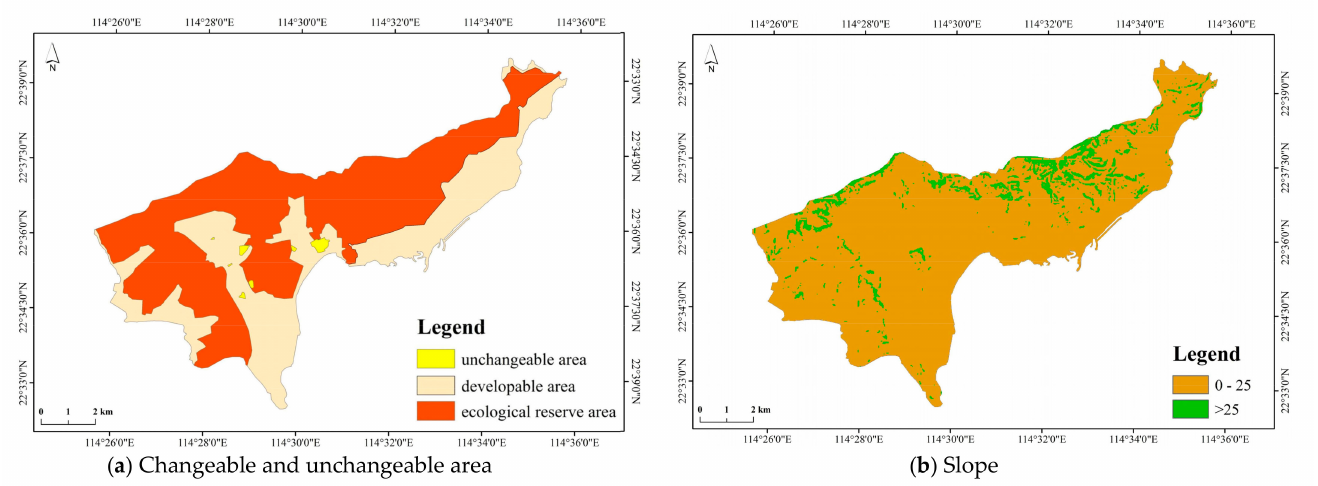
Figure 7. Constraints in Dapeng Community in relation to ( a ) changeable and unchangeable land, and ( b ) areas of allowable development where the land slope does not exceed 25